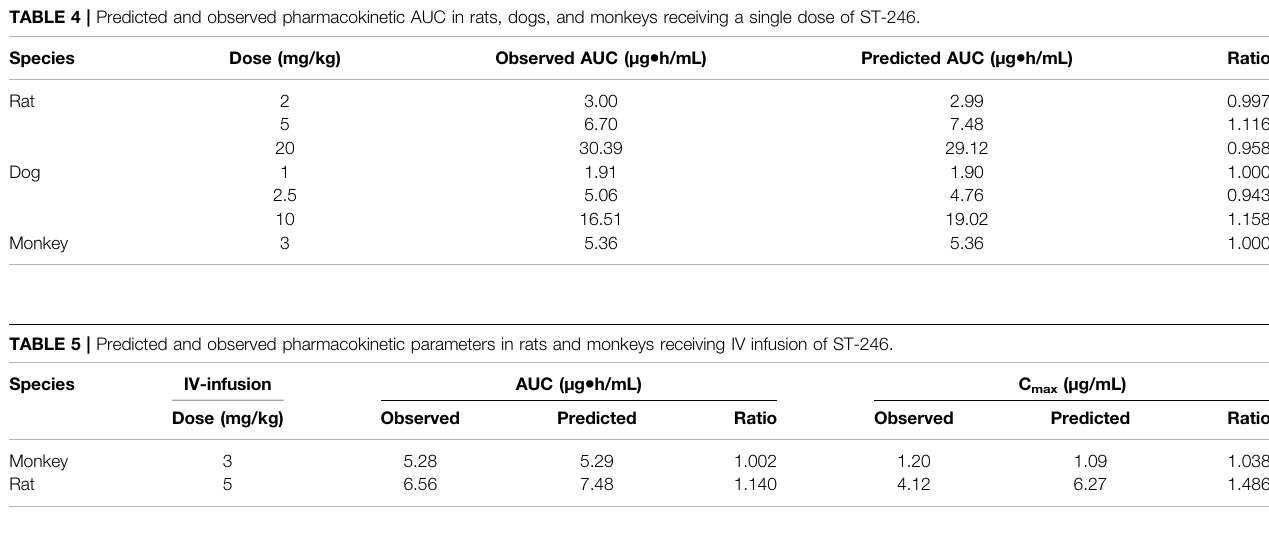
( Table 6 ) were predicted based on the linear clearance and volume of distribution. The reported PK pro fi les of ST-246 after oral dosing at the therapeutic dose (600 mg) on the 1st day and the 14th day with mean C max of 1.44 µg/mL and C min of 0.779 µg/mL led to good